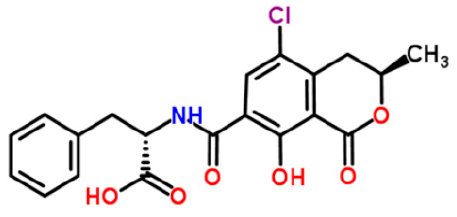
Figure 2. Ochratoxin A (structure from www.chemspider.com).